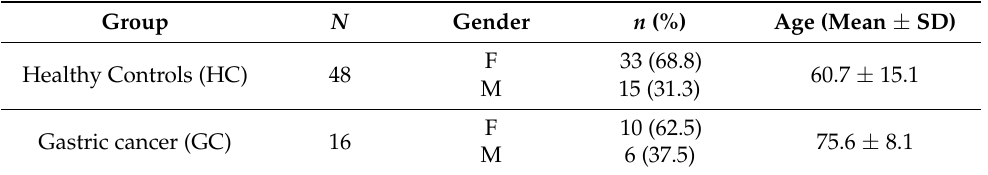
Table 2. Cell cycle genes differentially regulated in GES-1 and AGS cells after rhIL-33 stimulation. Using GES-1 as control cell line, we selected a subset of genes that were differentially regulated between the two cell lines. Table 3. Demographic of patients enrolled for bioptic specimen collection for the evaluation of cell cycle gene